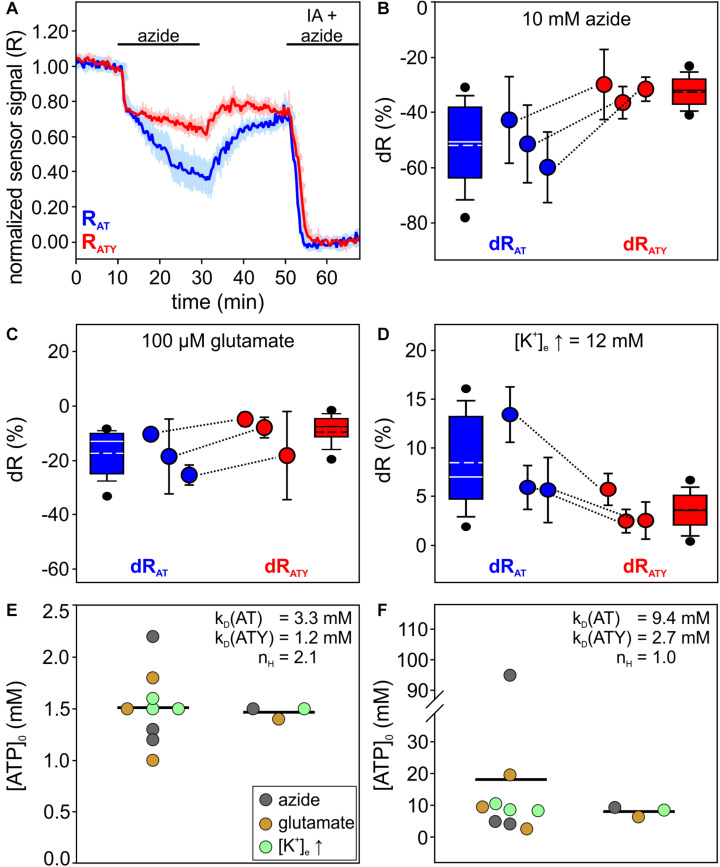
Determination of [ATP]0 in primary cultured cortical astrocytes using the dual nanosensor approach. (A) Time course of the signal of AT (blue) and ATY (red) during an experiment exposing the cells to azide (10 mM). At the end of the experiment, cells were treated with iodoacetate (IA) and azide to deplete cellular ATP. Shown is the normalized sensor signal R for all cells of one representative experiment (n = 25 cells for both AT and ATY; mean ± SD). (B–D) Signal changes dR obtained for AT (dRAT; blue) and ATY (dRATY; red) during incubation of astrocytes with azide (B; 10 mM, 20 min), glutamate (C; 100 μM, 15 min) or an increase in [K+]e (D; from 5.4 mM to 12 mM, 10 min). Shown is the distribution of dR of all cells (box plots), as well as the mean ± SD of each experiment (circles and error bars). Corresponding means of both sensors from the paired experiments are connected with lines. Each condition was replicated in N = 3 independent experiments. In each experiment, the following number of cells were analyzed: B, AT: 50, 50, 40. B, ATY: 48, 50, 47. C, AT: 50, 17, 40; C, ATY: 49, 44, 34. D, AT: 43, 46, 44; and D, ATY: 44, 46, 36. (E) [ATP]0 values calculated from the dRAT – dRATY pairs shown in panels (B–D), using the parameters indicated within the graph. On the left, values calculated from the dRAT – dRATY pairs from the paired experiments (circles) as well as the mean (line) are shown. Right: values obtained from the dRAT – dRATY pairs obtained from the pooled cells of all experiments. (F) Same calculation as in (E), but with different values of kD and nH as indicated within the graph.